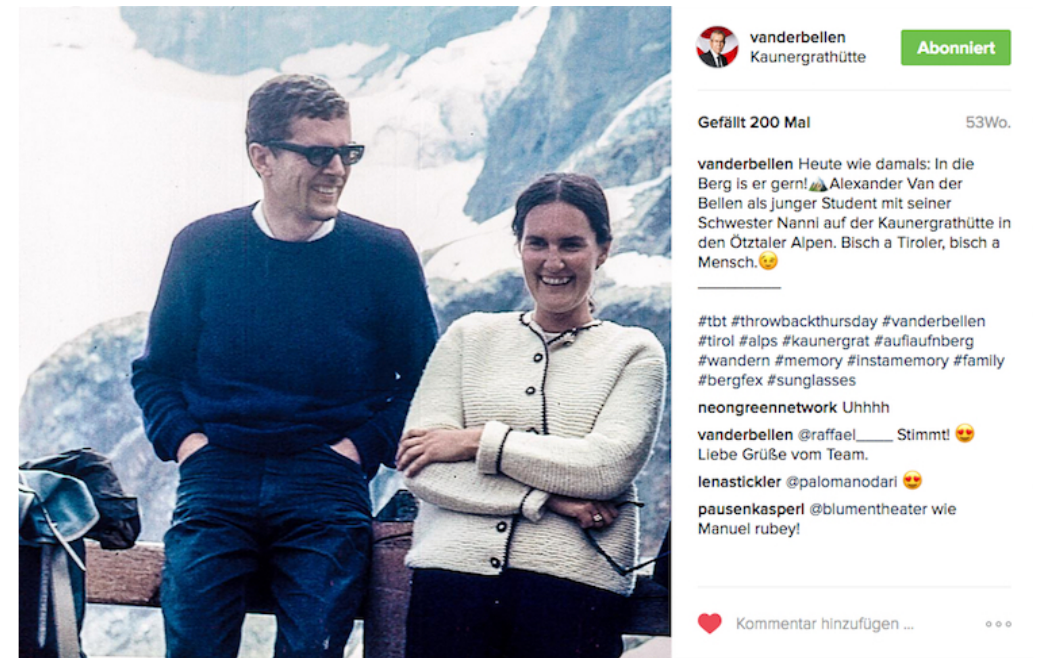
Figure 3. Throwback photo of Alexander Van der Bellen, posted on 4 February 2016.